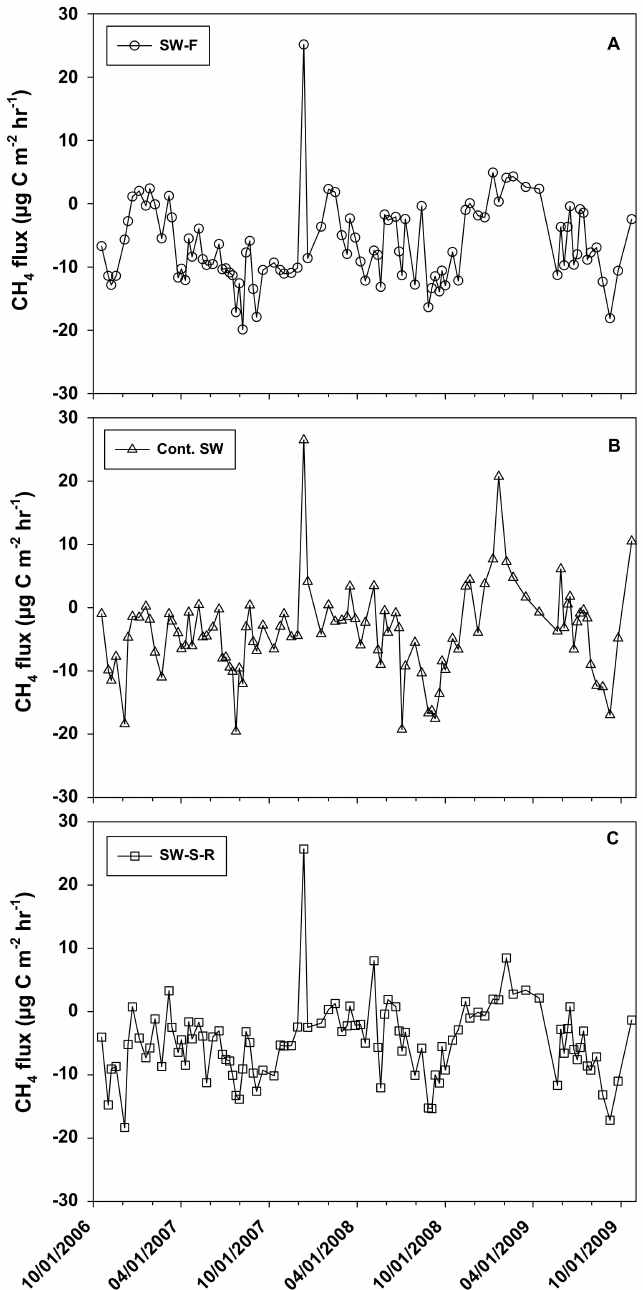
Figure 4. Methane flux for spring wheat–fallow (SW-F; ( A )), continuous spring wheat (Cont. SW; ( B )) and spring wheat–safflower–rye (SW-S-R; ( C )) cropping systems from 18 October 2006 through 23 October 2009. Mean values are reported across crop phases for SW-F and